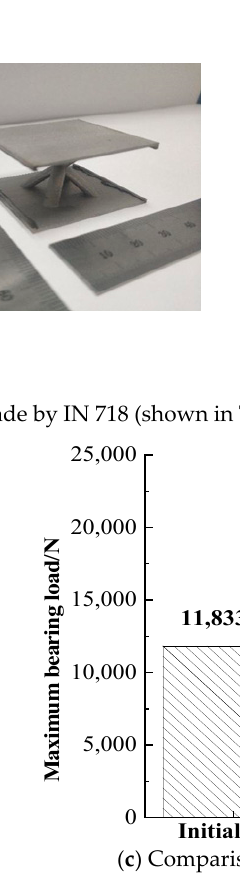
Figure 11. Validation XLS model and validation results: ( a ) XLS core; ( b ) force displacement curves; and ( c ) comparison for the maximum bearing load.